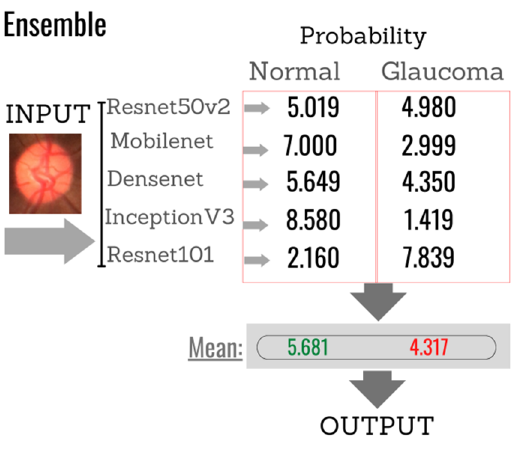
Figure 14. Example of the final response of the classifier based on the individual responses of each of the algorithms selected to compose the